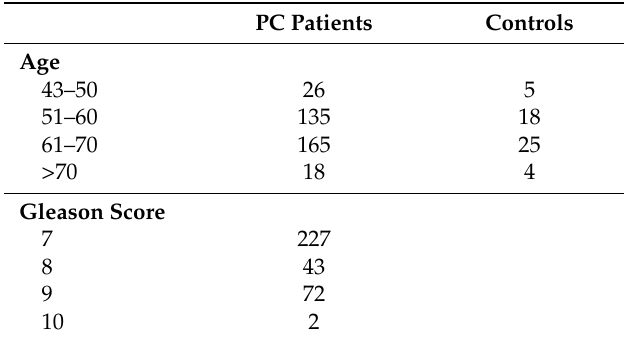
Table 5. Clinicopathological characteristics of PC and control